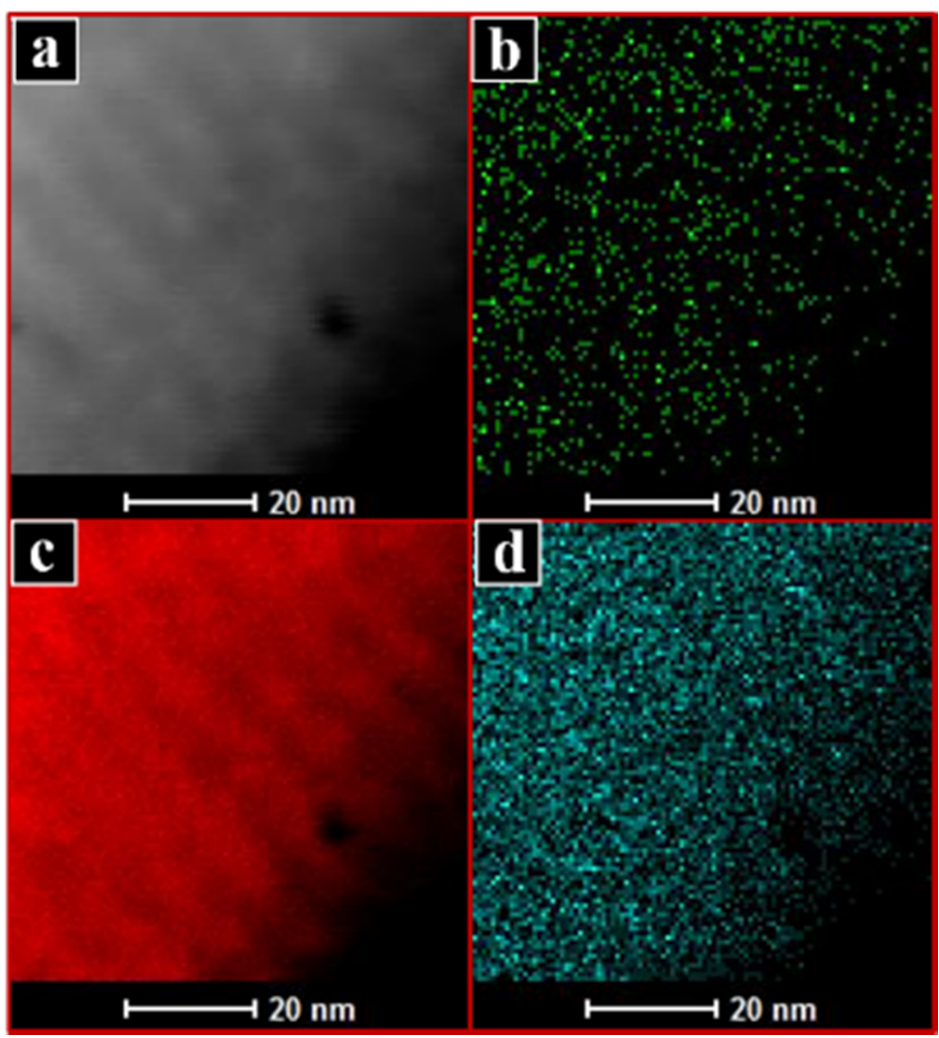
Figure 8. HAADF image of SL-Pd after catalyst testing ( a ), and corresponding EDS elemental maps of: Pd (K emission) ( b ); C ( c ), showing parallel pore structure; Pd (L emission) ( d ). Figure 4. presents HAADF images of the catalyst, IW-Pd, after catalytic activity